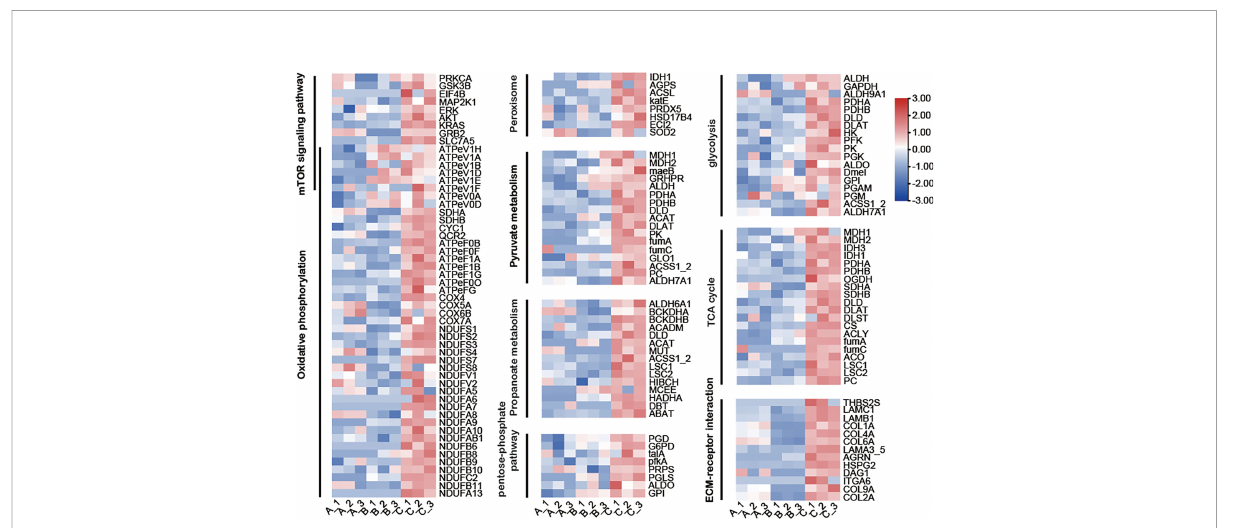
FIGURE 8 Heatmap showing changes in abundance of proteins in several major metabolic pathways. The color scale represents protein abundance normalized as Z-score, from blue the lowest to red the highest values. Red means up regulation, blue means down